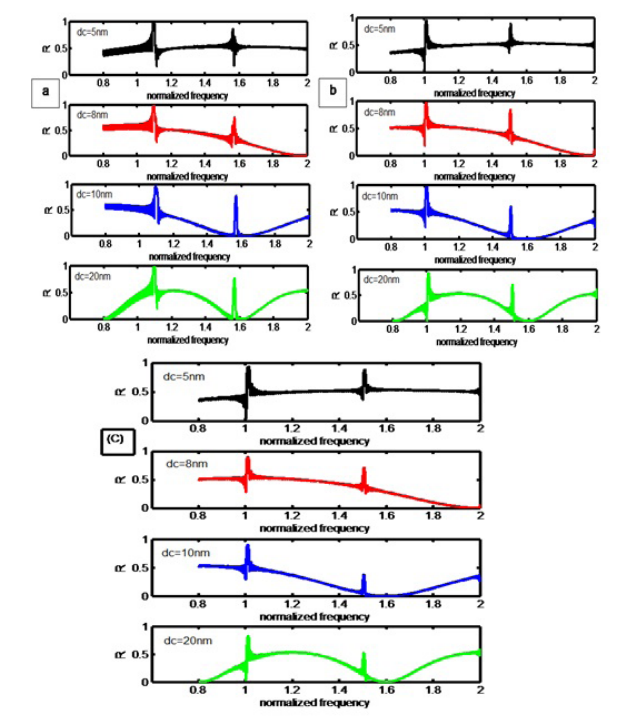
Figure 7. Reflectance spectra versus normalized frequency of the three periodic superconducting PC and for different values of the thickness, dc (nm) of the dielectric cap